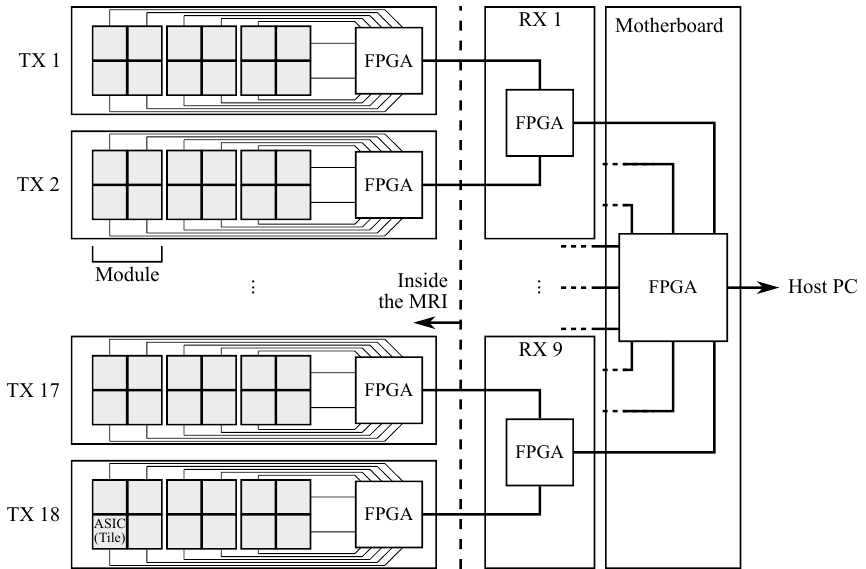
Figure 2. Schematic diagram of the acquisition pipeline from the ASICs to the host